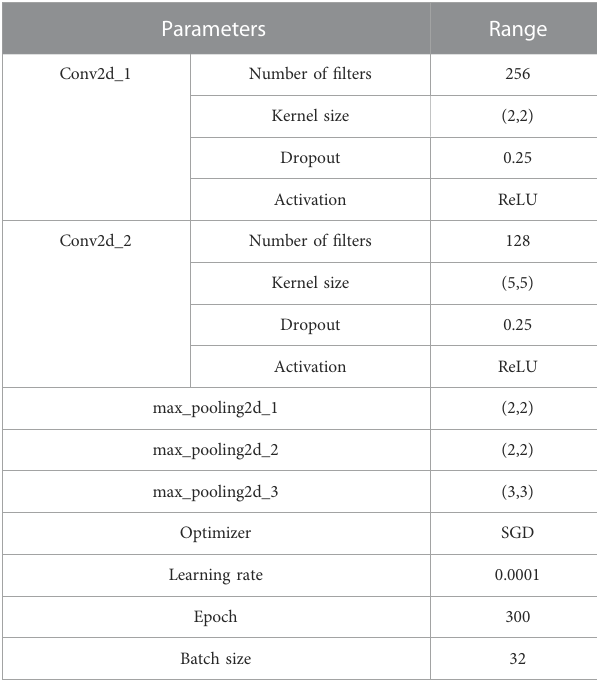
in the data, PCA enables the use of fewer dimensions while preserving most of the original data points ’ characteristics.